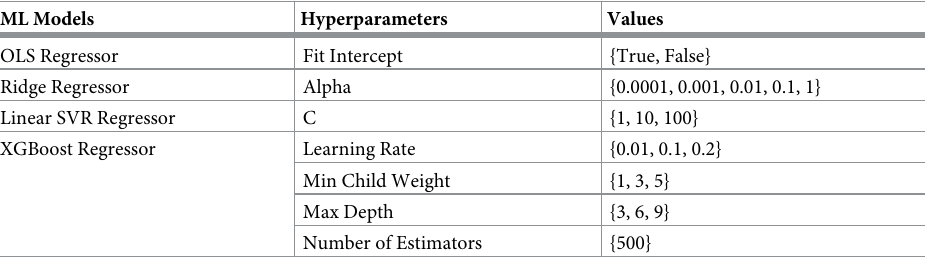
Table 2. Hyperparameter